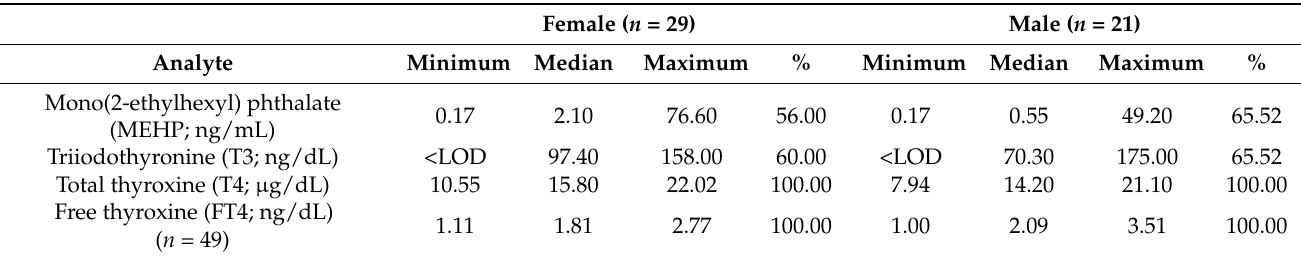
Table 2. Comparison of mono(2-ethylhexyl) phthalate (MEHP) and thyroid hormone concentrations by sex for individual dolphins ( n = 50 unless otherwise specified) sampled from Sarasota Bay, Florida (2010–2019). Frequency of detection given as %.